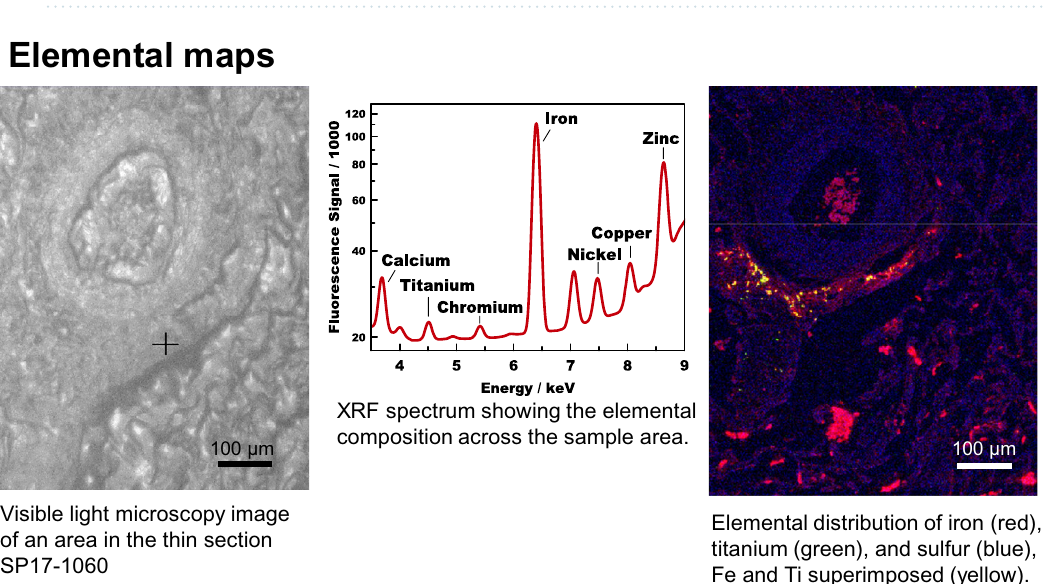
Figure 3. XANES spectra, taken beamline 5-ID of NSLS-II. Left: XANES spectra of an Fe-foil, a hematite and the lung sample at the Fe K-edge. Right: XANES spectra of an Ti-foil, TiO 2 , and the lung sample at the Ti K-edge.